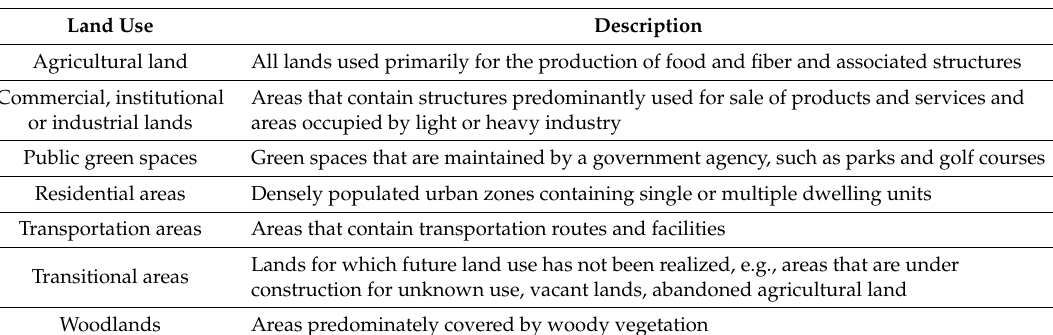
Table 1. Land use classification system used in this study.